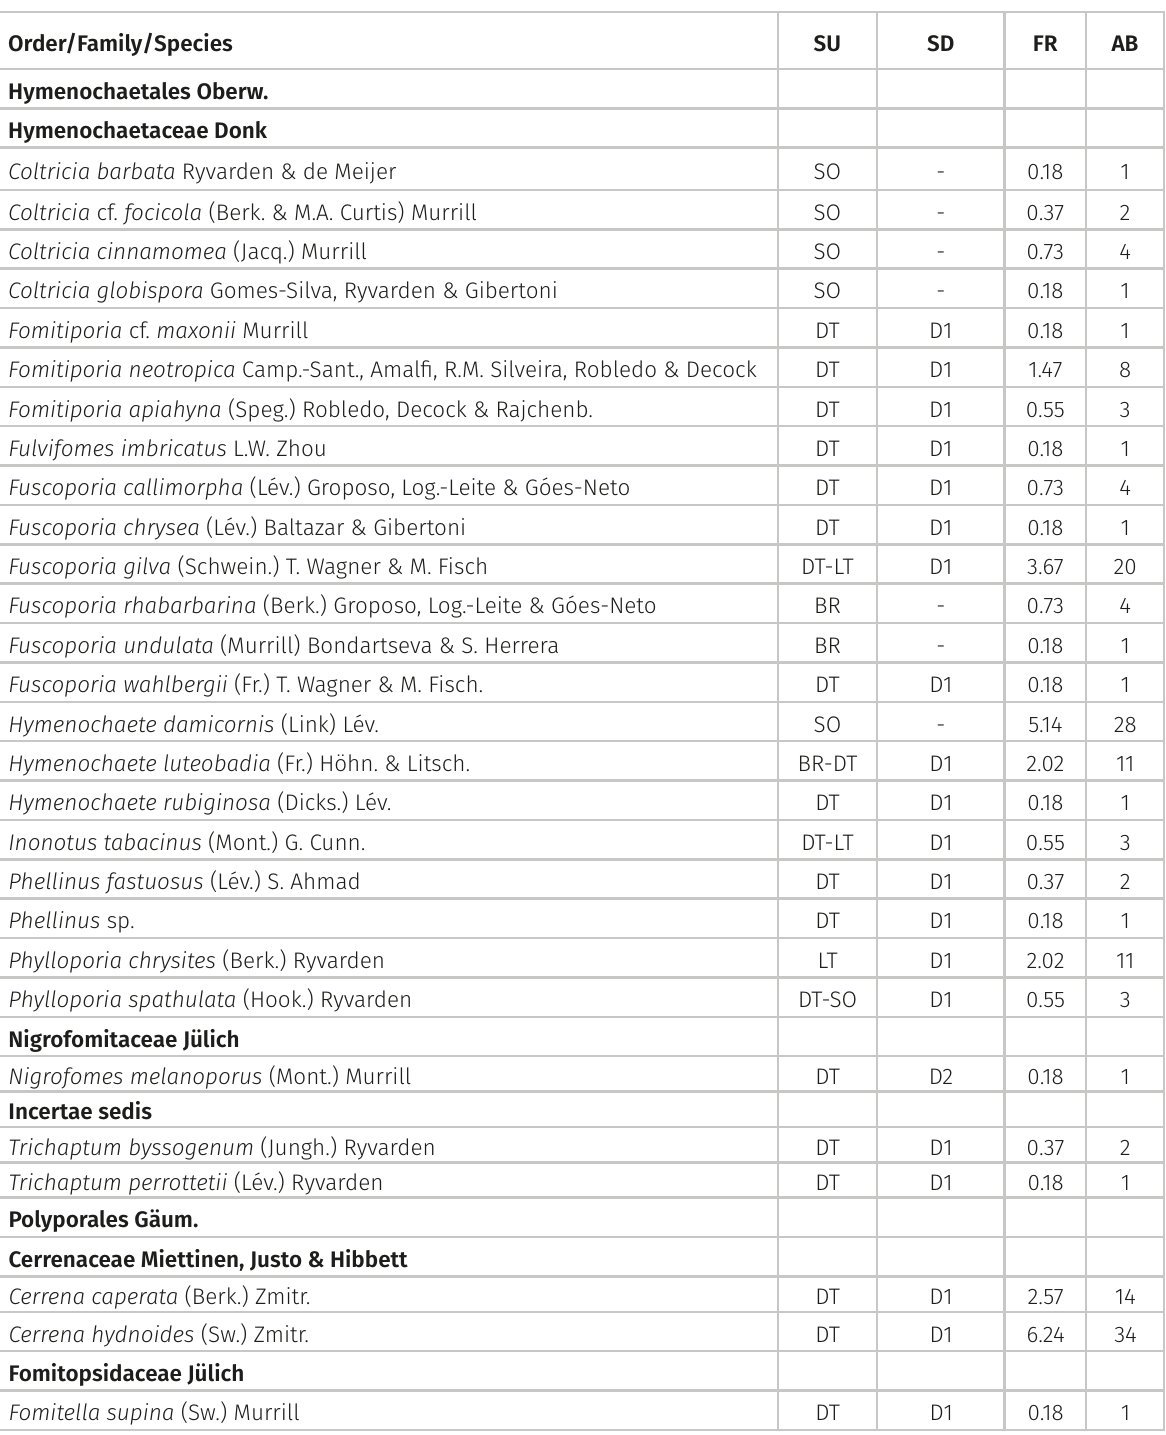
Table I. Families, genera and species of Hymenochaetales and Polyporales with their respective frequencies of occurrence (FR), abundance (AB), type of substrate (SU) observed (BR = Branch, LT = living trunk, DT = dead trunk, SO = soil) and stage of decomposition (SD) with the categories (D1 = rigid, D2 = intermediary, D3 = fragile) found near the Silvio Braga HPP, in Santarém,